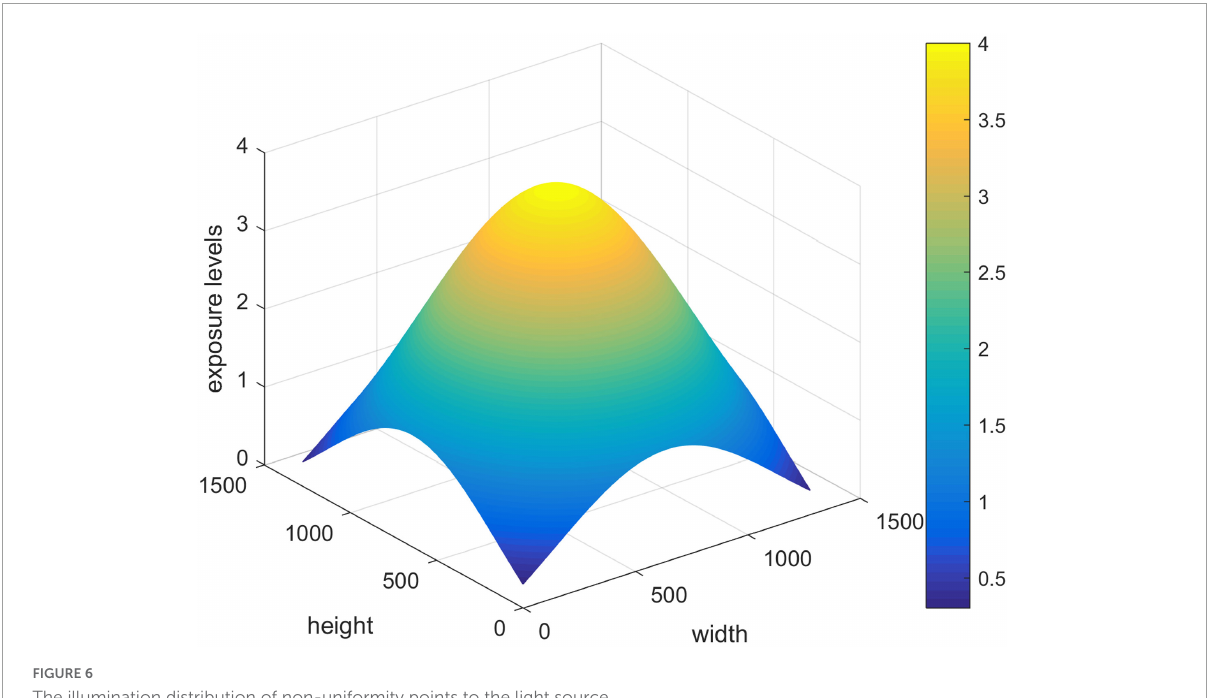
FIGURE6 The illumination distribution of non-uniformity points to the light source.